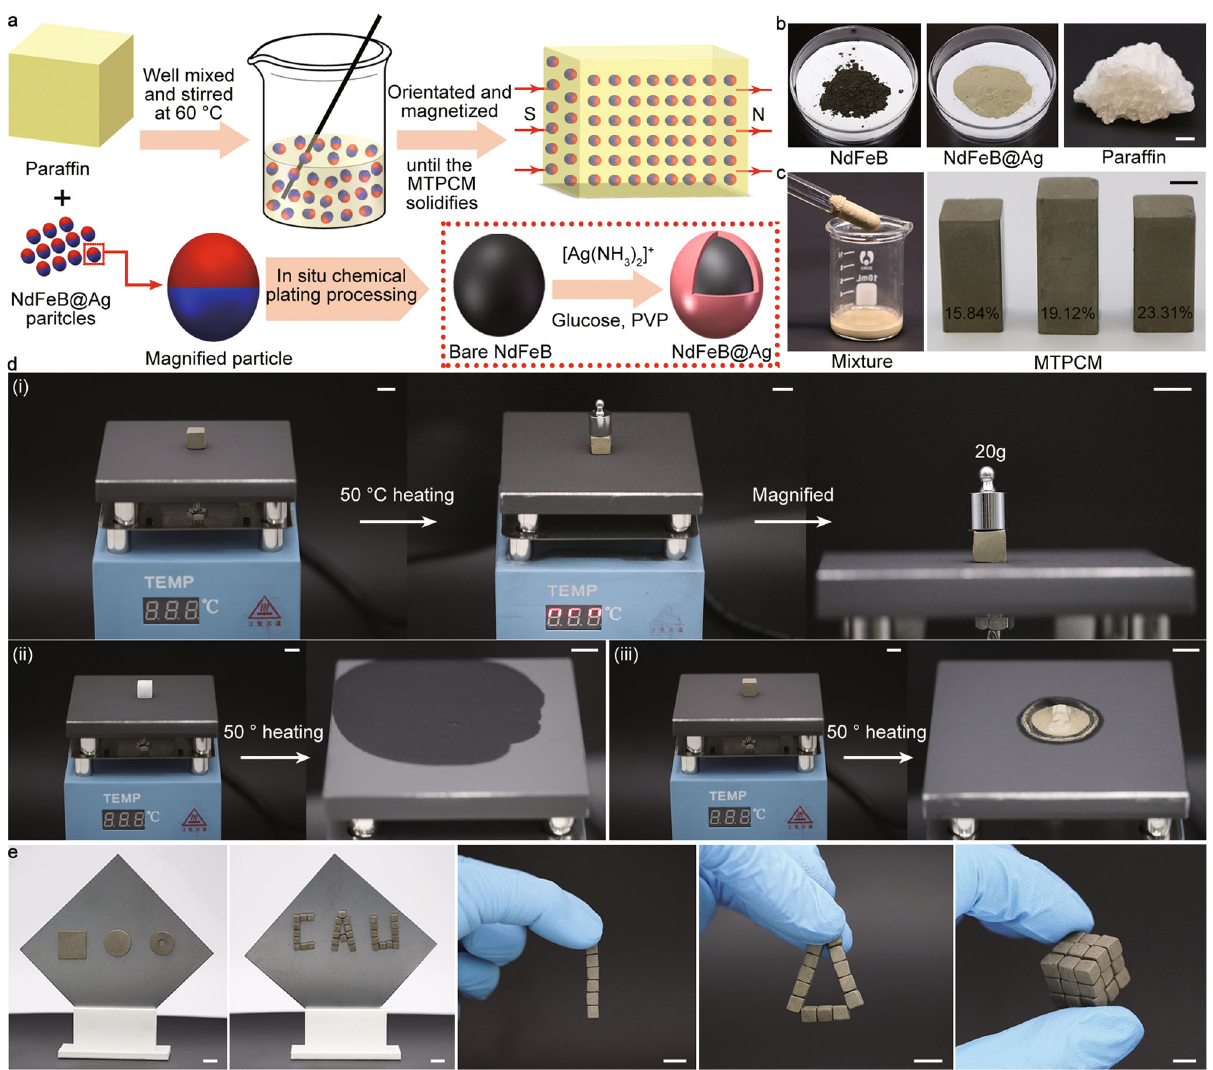
Fig. 1 Magnetically tightened form-stable phase change materials (MTPCMs) with magnetic assembly and conformal shape features. a Schematic procedure for fabricating MTPCMs. b Photographs of NdFeB, NdFeB@Ag, and paraf fi n. Scale bar: 5 mm c The mixture of NdFeB@Ag particles and paraf fi n, and MTPCMs with different volume ratios. Scale bar: 5 mm. d Shape stability and leakage behaviors of (i) MTPCM (ii) paraf fi n and (iii) unmagnetized composite during the phase change process. Scale bars: 10 mm. e Modular assembly and conformal geometry features of MTPCMs. Scale bars: 10